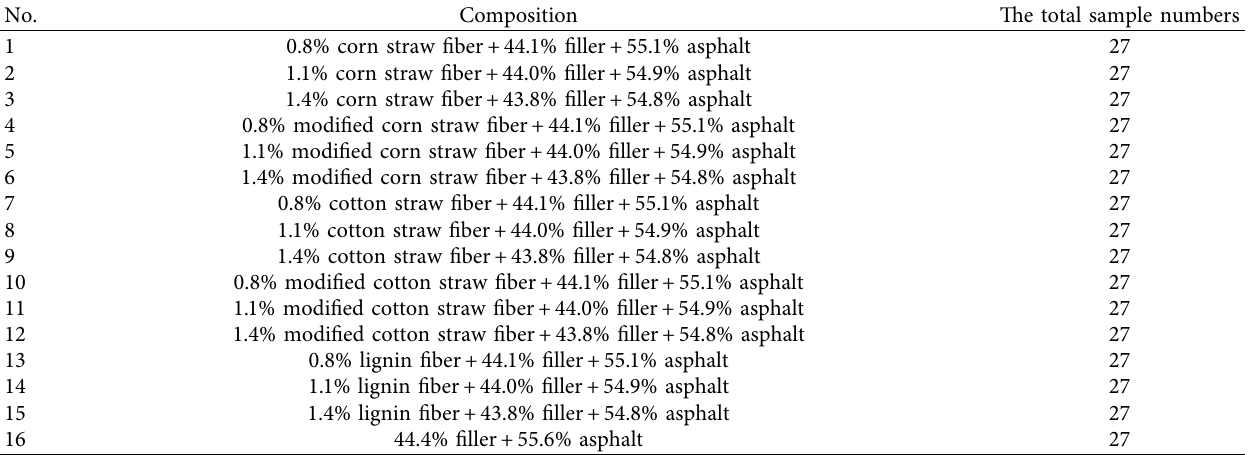
Table 4: Te composition of samples.